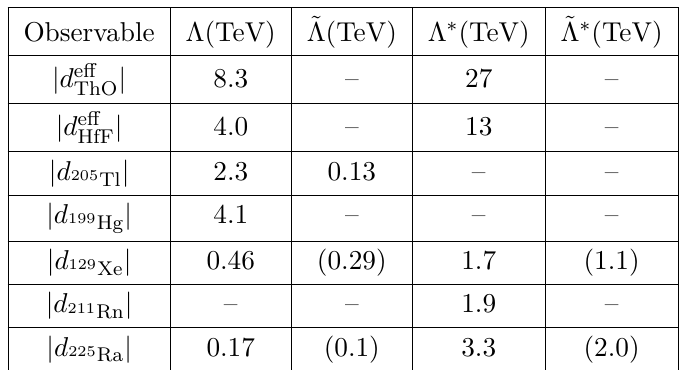
Table 5 . Lower bound on the e(cid:11)ective scale (cid:3) in the de(cid:12)nition eq. (2.2) and eq. (2.3). See text for detailed